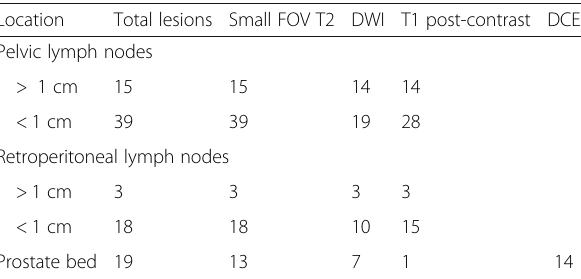
Table 3 Correlate detection for PSMA-avid foci by sequence in the abdomen or pelvis Location